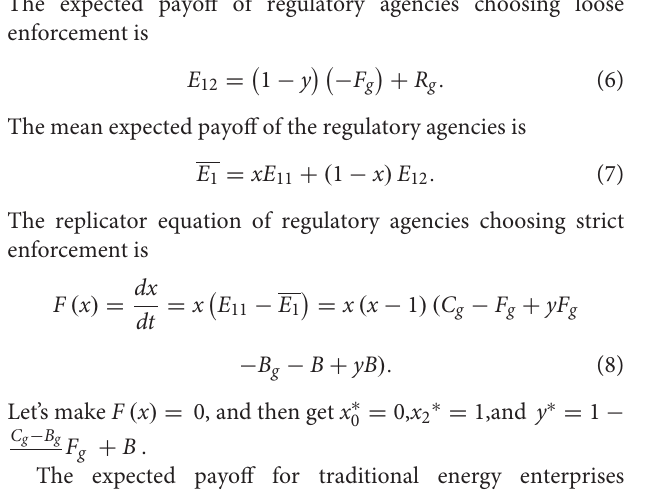
TABLE 4 | Regulatory agencies’ and traditional energy enterprises’ evolutionary game local equilibrium points.